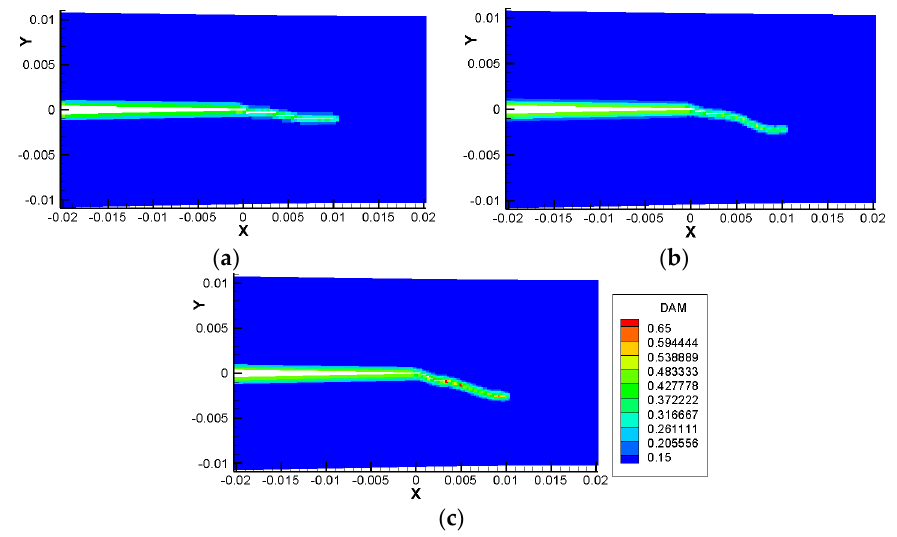
Figure 5. Crack path with different m (δ = 1 mm) values using PD models at 80 µs. ( a ) m = 3 (Δ x = 0.33 mm);